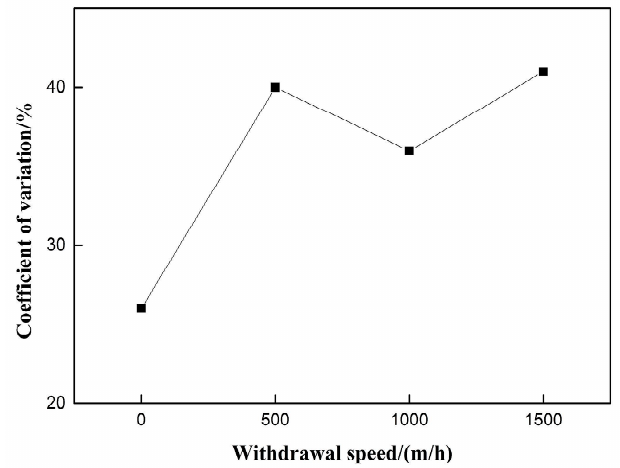
Figure 10. E ff ect of withdrawal speed on coe ffi cient of Figure 10. Effect of withdrawal speed on coefficient of variation.